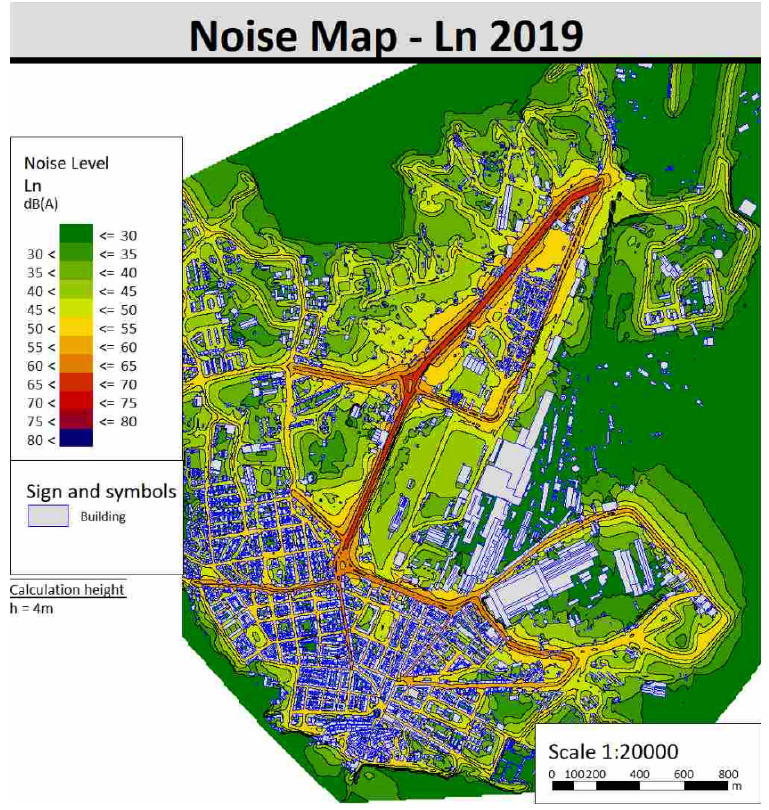
Figure 14. Noise maps of Piombino with L n indicator for 2019.